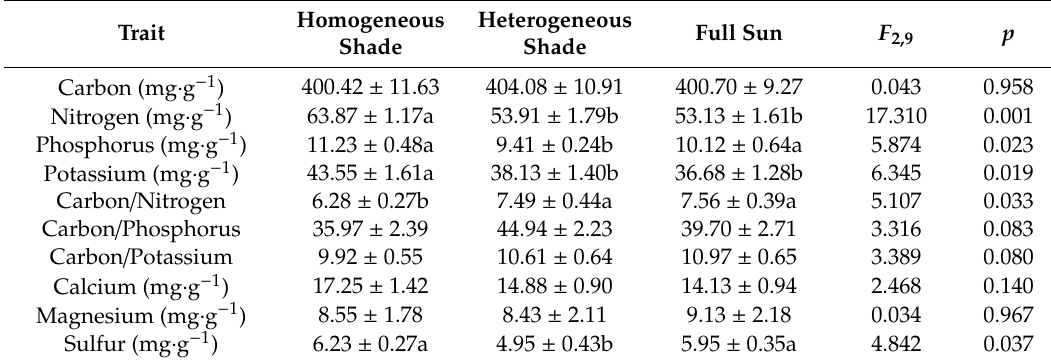
Table 4. Elemental concentrations and stoichiometry of the Glycine max leaves following plant growth in homogeneous 62% sunlight exclusion under a shade screen, heterogeneous 62% sunlight exclusion under a slat-house, or full sunlight. Mean ± SE, n =